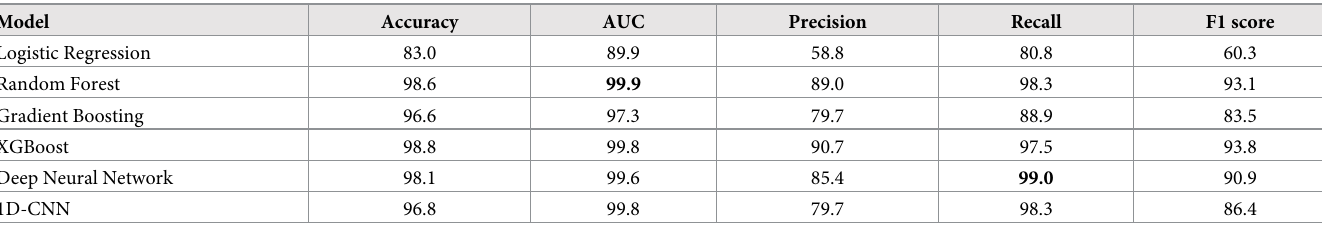
Table 6. Evaluation performance of the ACS prediction model after feature selection and hybrid sampling.